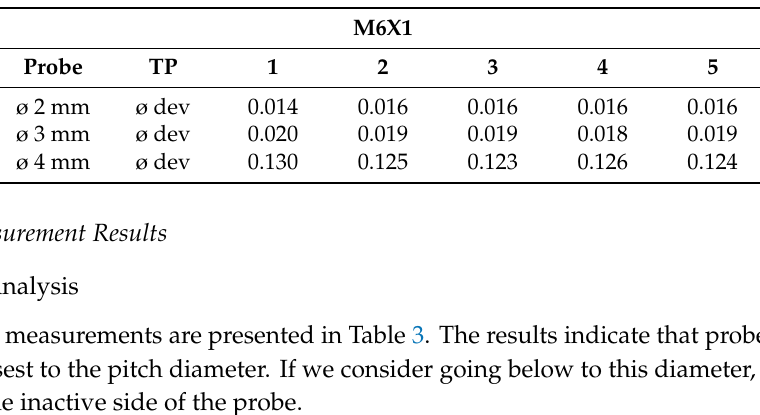
Table 2. TP of the thread resulted by measuring using 3 probes and 5 measurements.